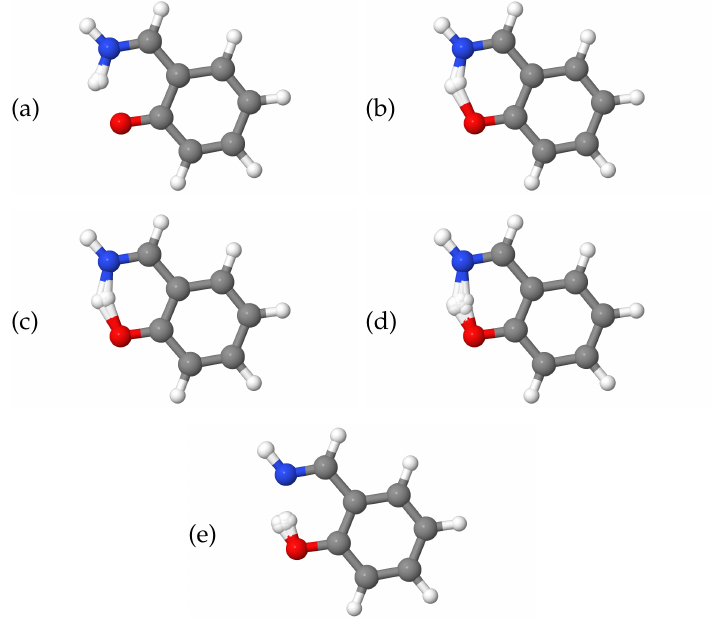
Figure 2. Sampled geometries of salicylaldimine grouped according to their associated diffusion coordinate, θ 2 : ( a ) − 0.3 < θ 2 < − 0.2; ( b ) − 0.2 ≤ θ 2 < − 0.1; ( c ) − 0.1 ≤ θ 2 < 0.0; ( d ) 0.0 ≤ θ 2 < 0.1; ( e ) 0.1 ≤ θ 2 <